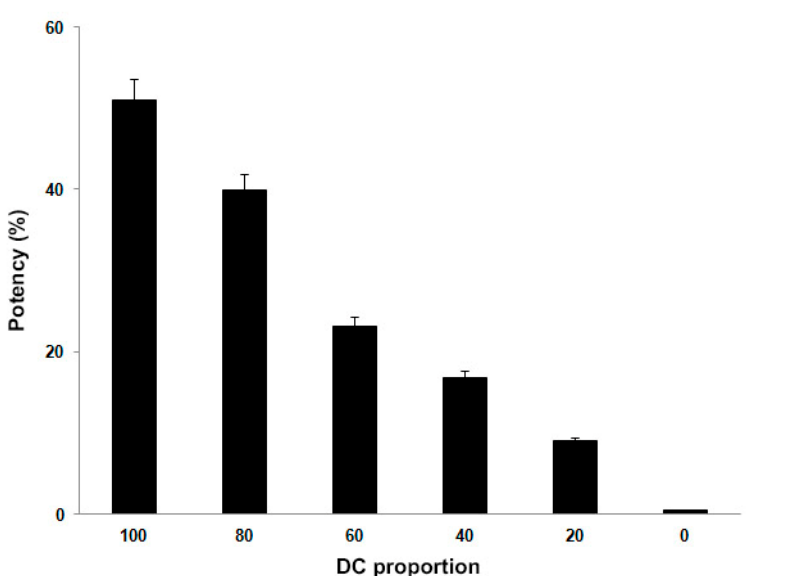
Figure 3. Selectivity of the bioassay. Potency data obtained adding various proportions of CD14+ cells to three different batches of DCs. Results are reported as mean ± SD.